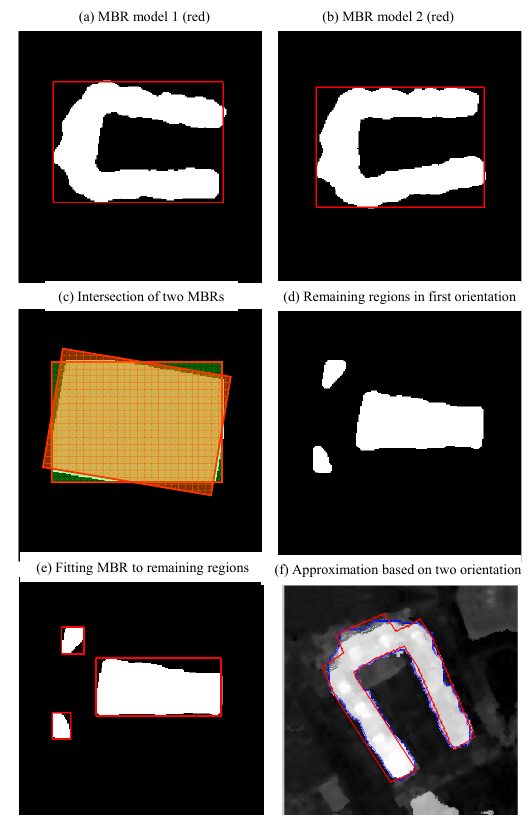
Figure 7: CMBR based polygon approximation 7(e), yellow region). The first approximation area is subtracted from original binary region to generate the remaining